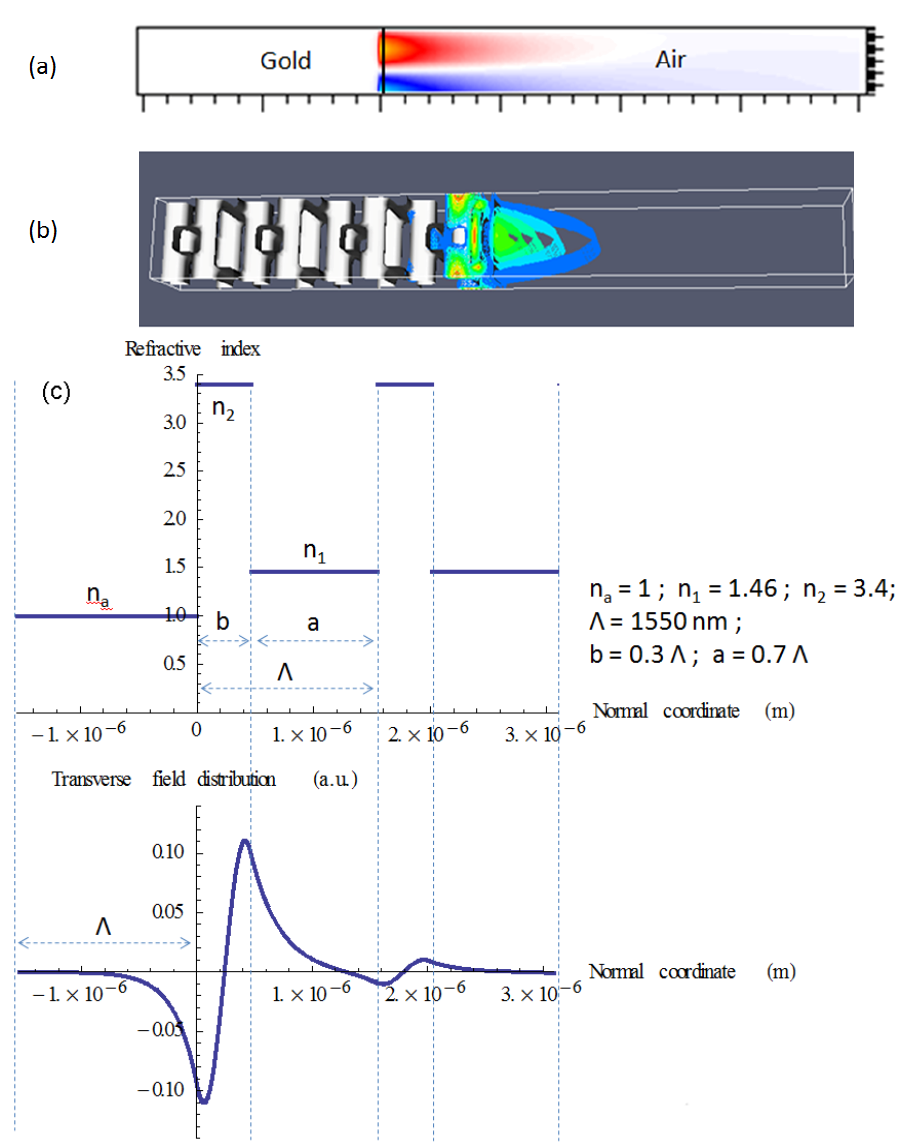
Figure 8. Mode profiles of surface modes: (a) Field penetration in air for SPP mode component is shown. The frequency is chosen to be formed by air-gold interface. The H y close to cut-off so that field penetration is large in air. (b) Field profile |E| of surface Bloch mode induced on air/woodpile interface. The analysis results will be reported